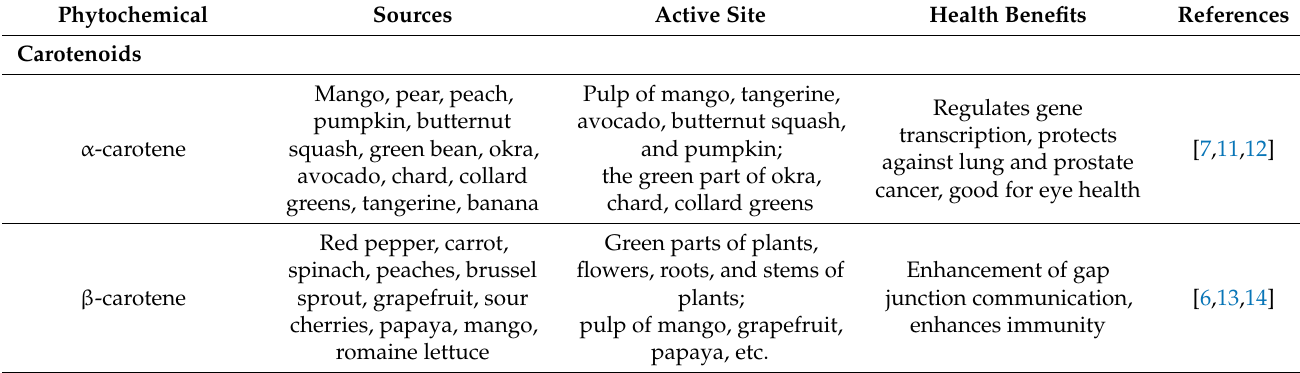
Table 1. Major phytochemicals, their sources, active sites, and the related health